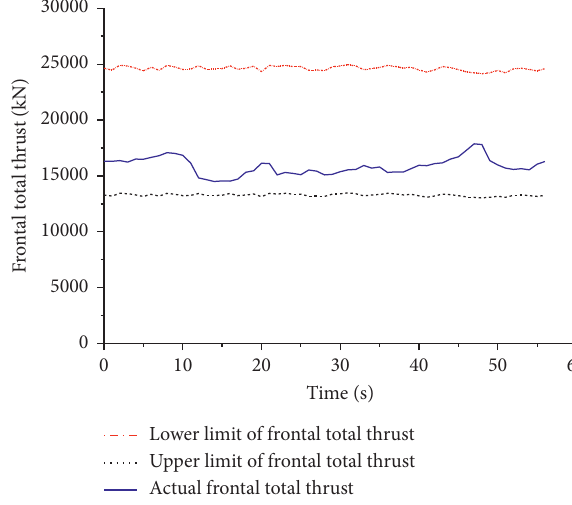
Figure 23: Total thrust variation curve. Table 6: Thrust ratios at corresponding measuring points.